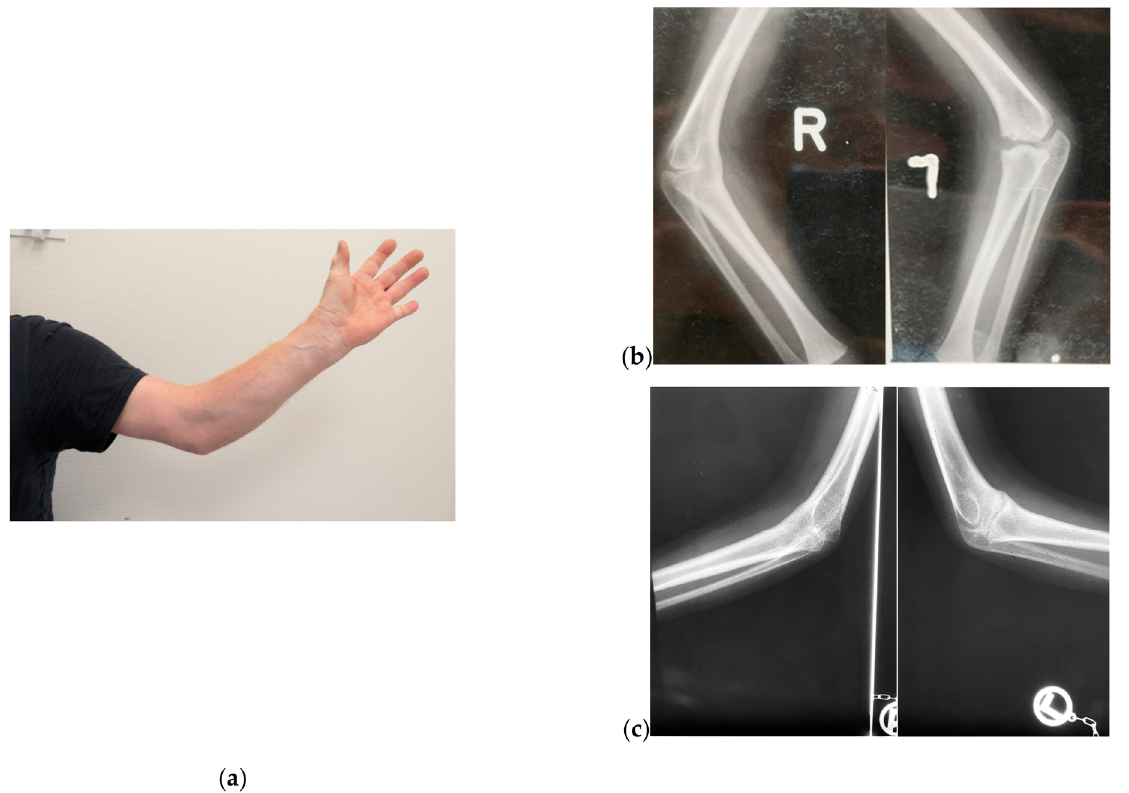
Figure 4. Photographs of patient V.1. ( a ) Left elbow: the patient has no range of motion of the